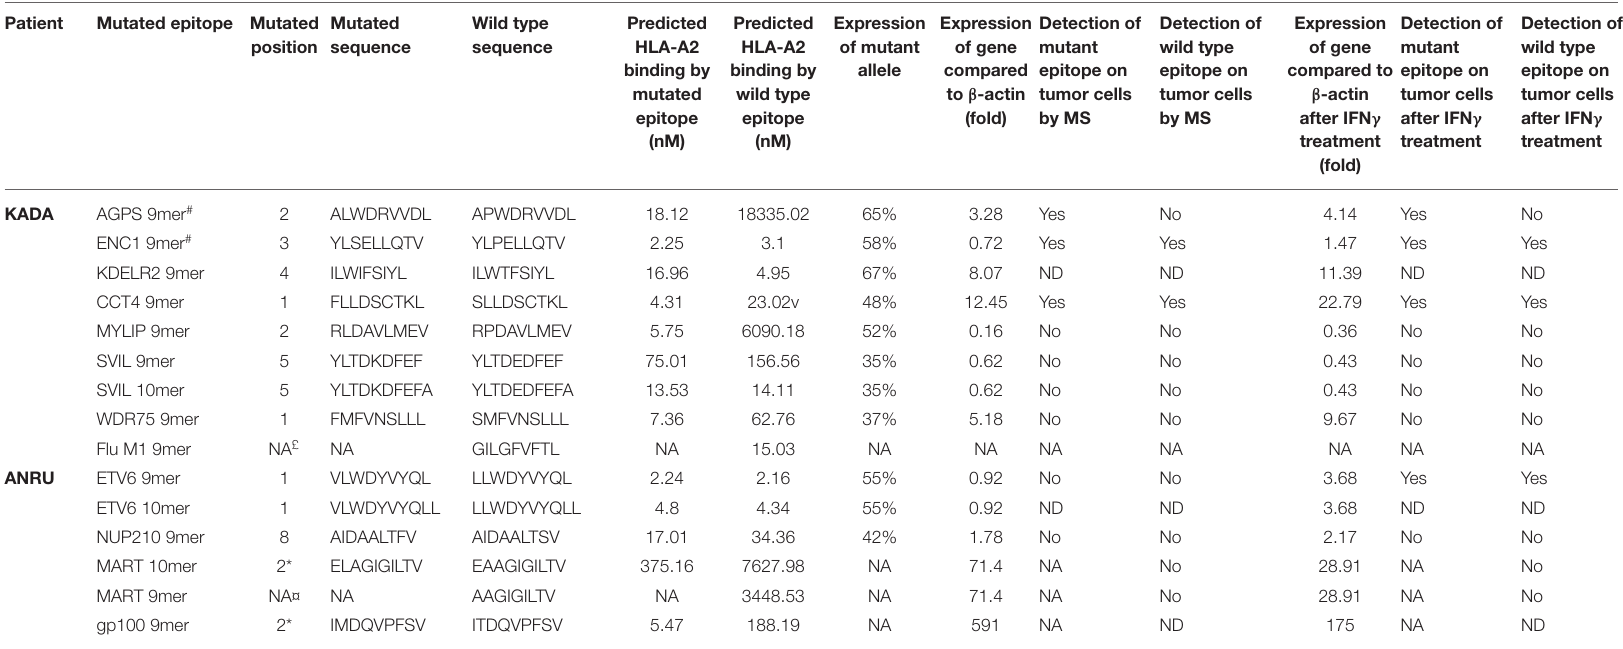
TABLE 2 | Analysis of predicted HLA-A2 binding mutated or tumor associated peptides that trigger activation of tumor-infiltrating lymphocytes and/or are detected in pMHC complexes by MS. Patient